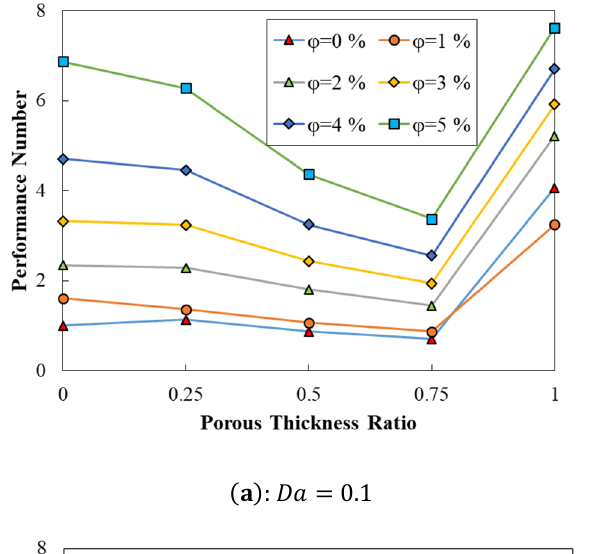
Figure 7. Performance number versus porous thickness ratio for diverse volume fractions at differ- ent Darcy numbers (case I).